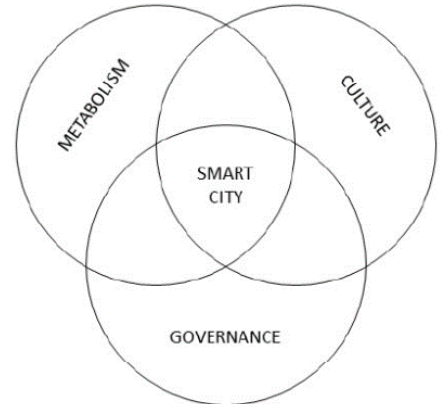
Figure 2. Proposed Smart City framework (Allam and Newman